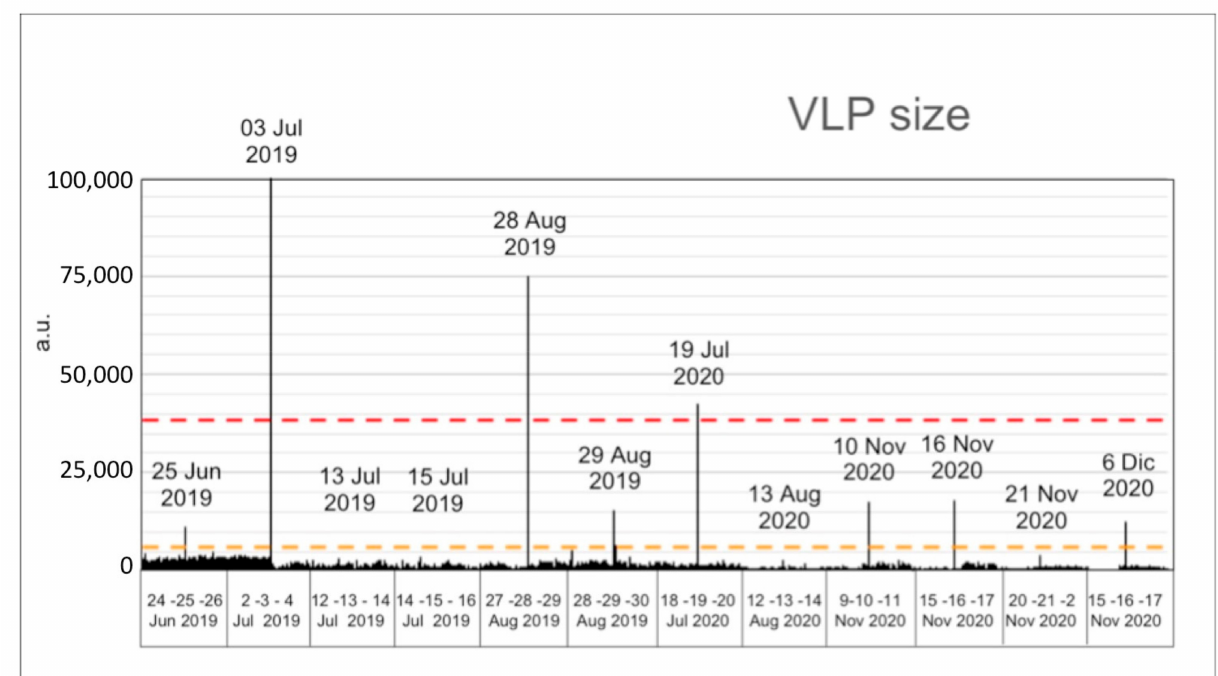
Figure 18. VLP size calculated in twelve 24-h intervals, each containing one of the twelve explosions selected as case studies. The histogram is normalized to 100,000 in arbitrary units (a.u.). The dashed orange line indicates the VLP size threshold, which separates the ordinary from the major explosions. The red dashed line indicates a possible VLP size threshold to separate major explosions from paroxysms (3 July 2019, 28 August 2019 and 19 July 2020). Note that this is not a time series in the whole considered period, but is representative only of the days reported in the abscissa axis. In this way, it is possible to observe how the VLP size of the most energetic explosive event far exceeds the VLP size of the “ordinary” explosions that occurred in the 24 h around